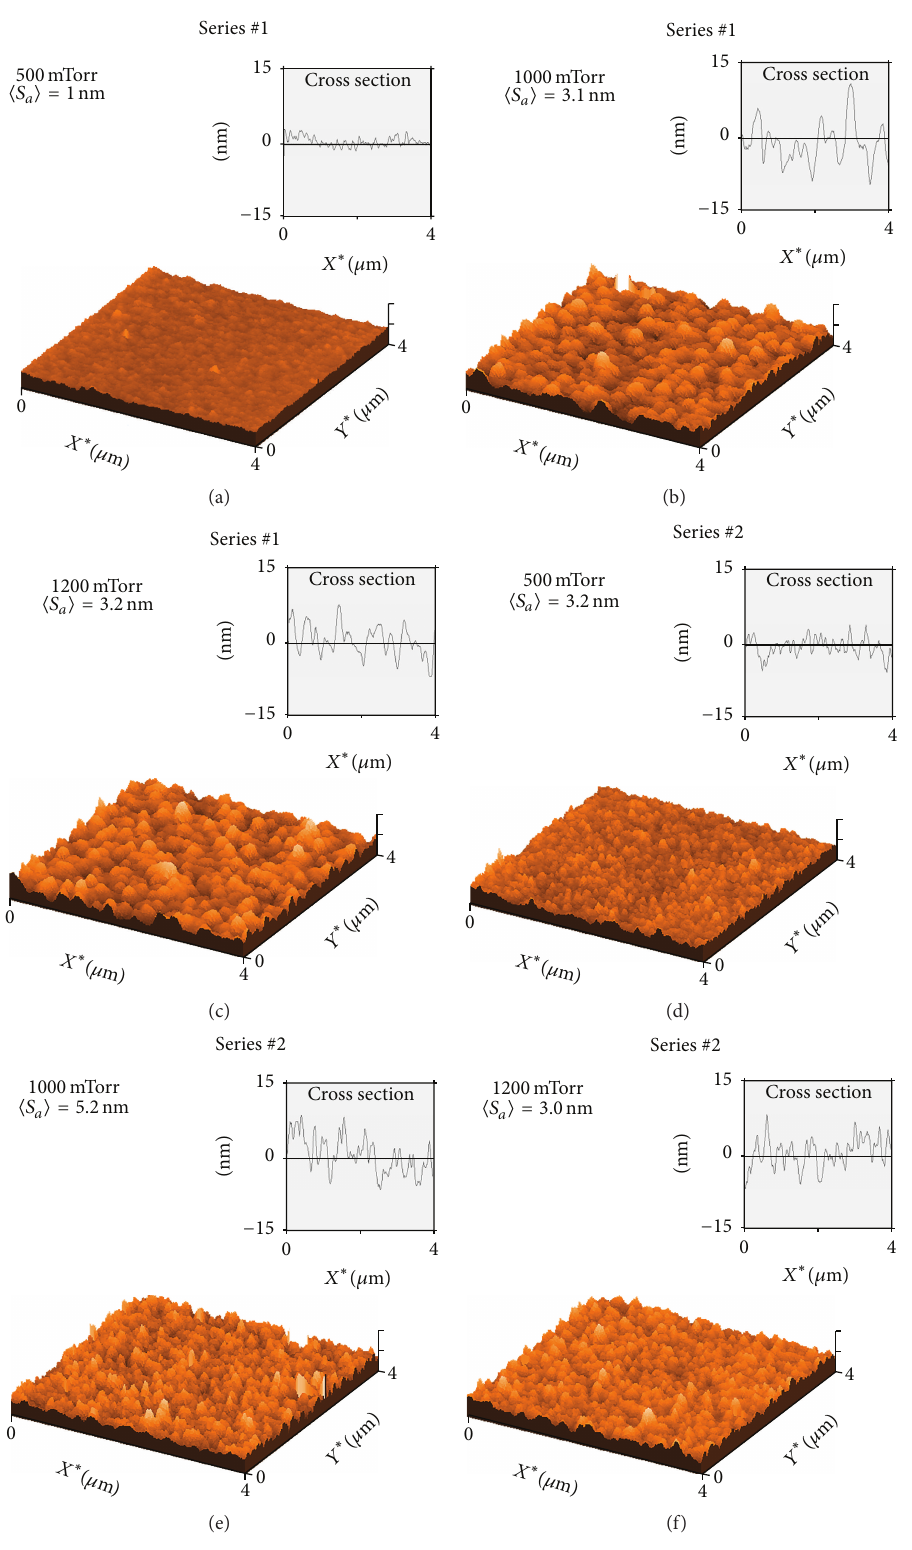
Figure 2: Surface analysis by AFM in pm-Si 𝑥 Ge 𝑦 :H films, corresponding to (a) Series #1: 500 mTorr, (b) Series #1: 1000 mTorr, (c) Series #1: 1200mTorr. (d) Series #2: 500 mTorr, (e) Series #2: 1000mTorr, and (f) Series #2: